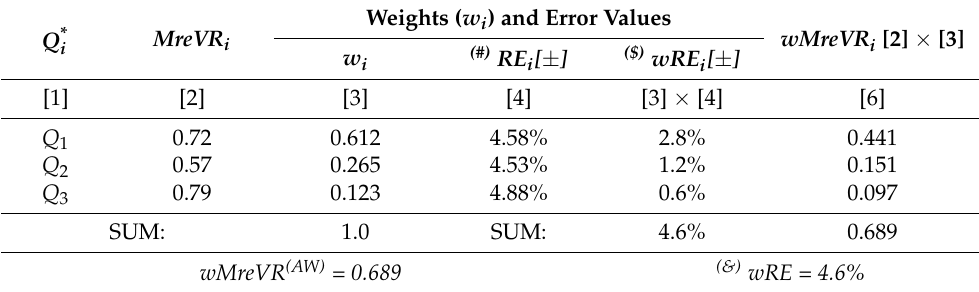
Table 13. Input for wMreVR (AW) calculation.